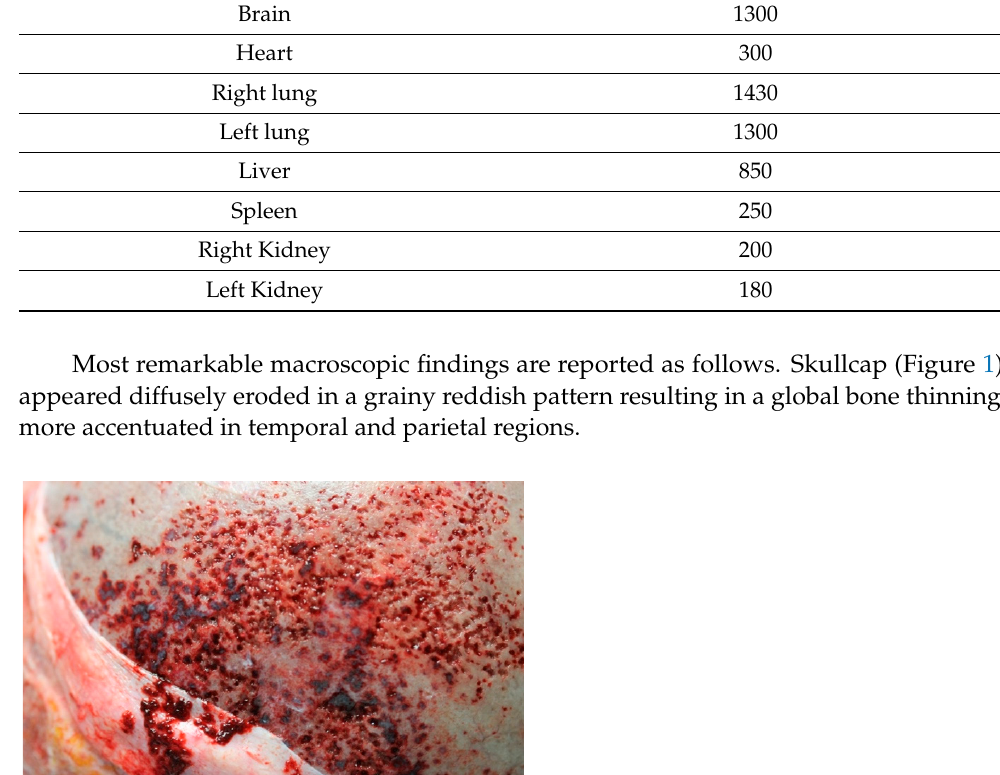
Table 1. Organ weights in grams (g).